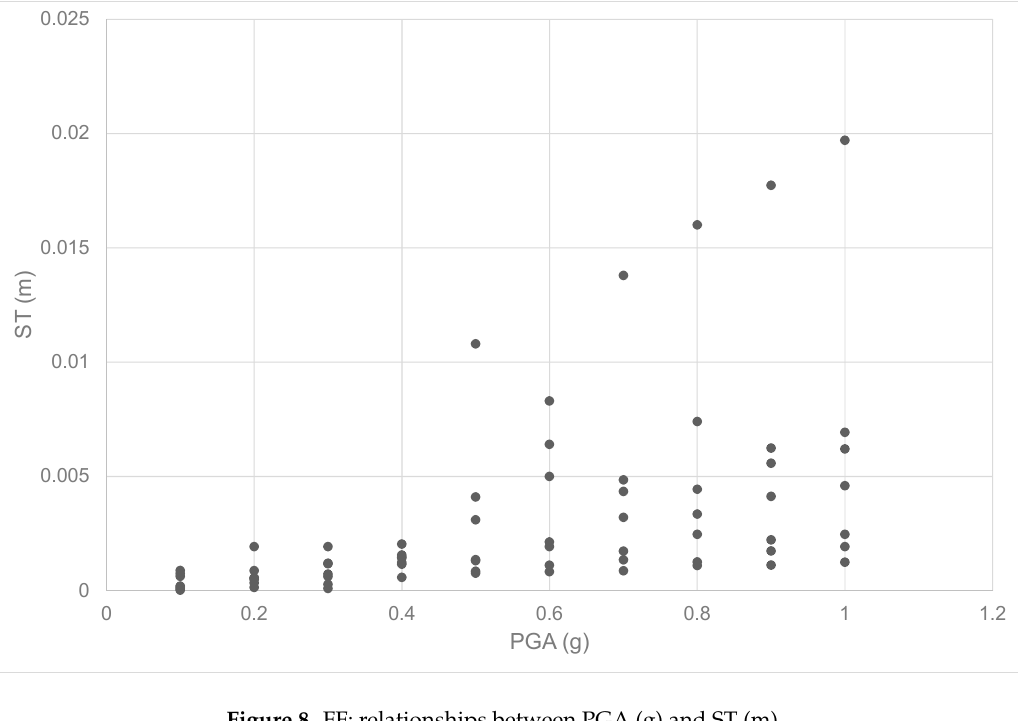
Figure 8. FF: relationships between PGA (g) and ST (m). Table 8. Free field (FF): lognormal parameters.